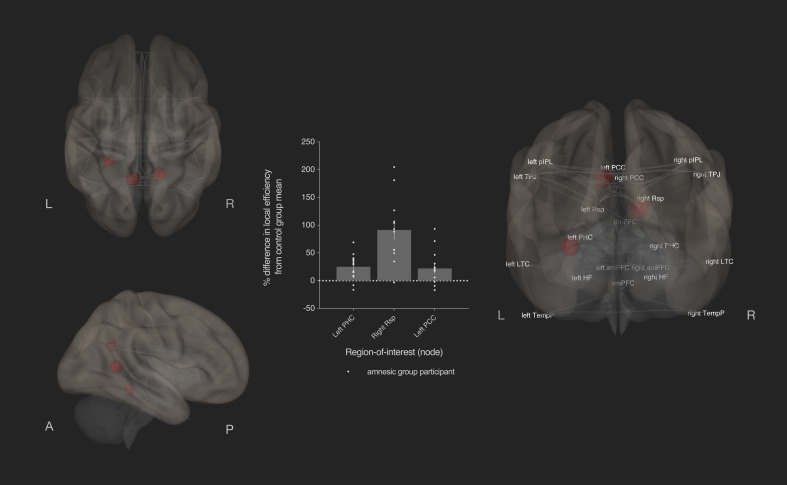
Bilateral damage to human CA3 increased local efficiency in three DN nodes.Results from graph theoretic analyses of the DN in the amnesic and control groups, derived from 4-D rs-fMRI EPI acquired at 7.0-Tesla MRI field strength. 3-D rendered brain depicts nodes (DN vertices/brain regions-of-interest) and their associated edges (paths between nodes) used to define the DN. The size of a node represents the beta value for that node. Network edges (adjacency matrix threshold): z > 0.84, one-sided (positive); and, analysis threshold: two-sided p-FDR corrected <0.05 (two-sided). Local efficiency was significantly increased in three nodes: left posterior cingulate cortex (left PCC) (MNI co-ordinates −8,–56,26, β = 0.35, t = 3.49, p-FDR = 0.020), left parahippocampal cortex (left PHC) (MNI −28,–40,−12, β = 0.45, t = 3.25, p-FDR = 0.037) and right retrosplenial cortex (right Rsp) (MNI 14,–52,8, β = 0.36, t = 3.45, p-FDR = 0.020). Plot depicts differences in local efficiency in amnesic group participants from the mean of the control group. Differences in local efficiency at these nodes from the mean of the control group were not predictive of internal (episodic) detail performance on the AI (i.e., mean composite internal details score across all intervals) (Supplementary file 1q). Renders are depicted at the same threshold as that used to assess significance (i.e., p-FDR corrected <0.05 [two-sided]). Comparable between-group differences in network topology were observed when an alternate threshold was used to test for functional connections (see section on stability of the effects and Supplementary files 1h–1m). Plot depicts mean local efficiency at these three nodes. Error bars correspond to the s.e.m.. *p<0.05.